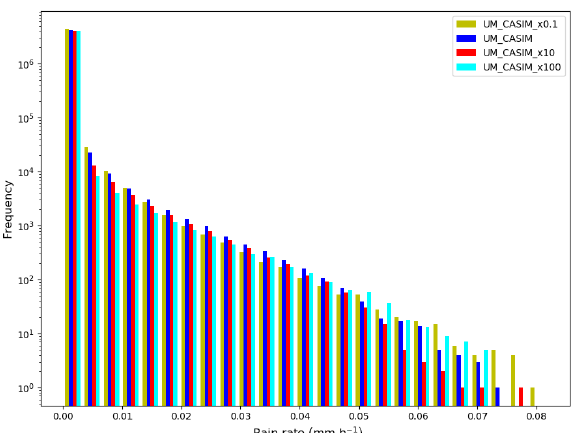
Figure 11. Histograms of rain rate, taken for all columns containing